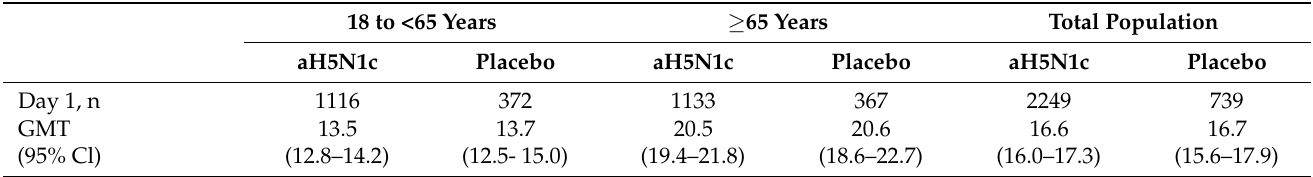
Table 2. HI antibody responses (GMT and GMR) against H5N1 at Day 1, Day 22, Day 43, and Day 183 by age